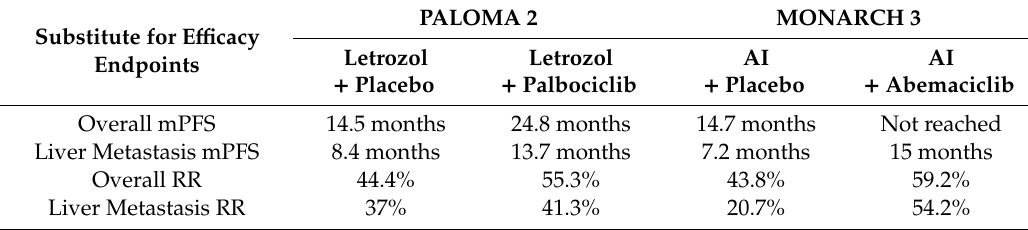
Table 3. Activity of palbociclib and abemaciclib according to patients’ clinical